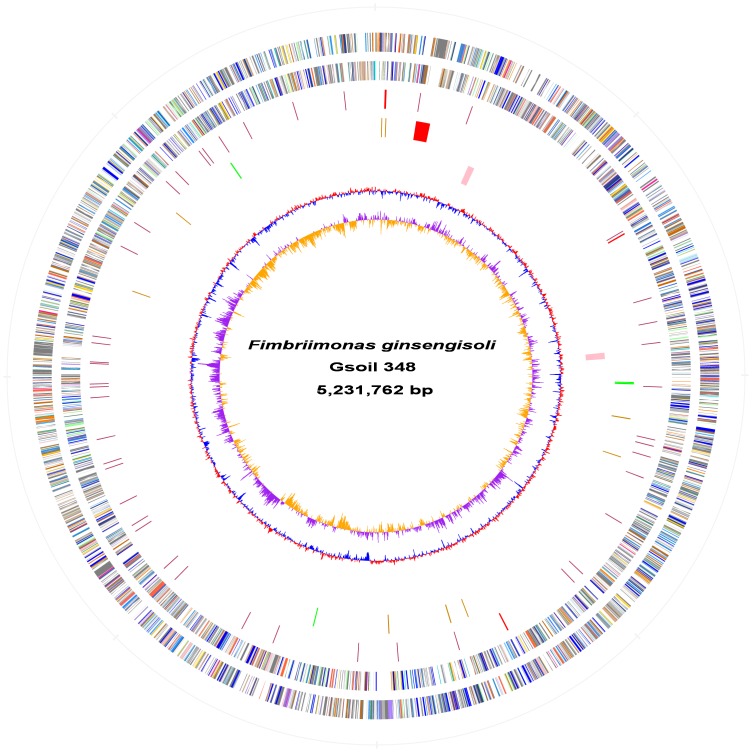
Genome Atalas of Fimbriimonas ginsengisoli Gsoil 348T.Moving inside, each concentric circle represents genomic data for strain Gsoil 348T. The outer two circles illustrate predicted coding sequences on the plus and minus strands, respectively, colored by functional categories according to COG classification. The 3rd circle displays rRNA (red) and tRNA (maroon). The 4th circle shows loci of prophage (red), IS elements (orange) and the four horizontal transferring regions (green). The 5th circle presents two putative gene clusters (pink). The 6th circle represents mean centered G+C content of the genome (red-above mean, blue-below mean). The 7th circle (innermost) represents GC skew (G-C)/(G+C) calculated using a 2 kb window in steps of 1 kb.